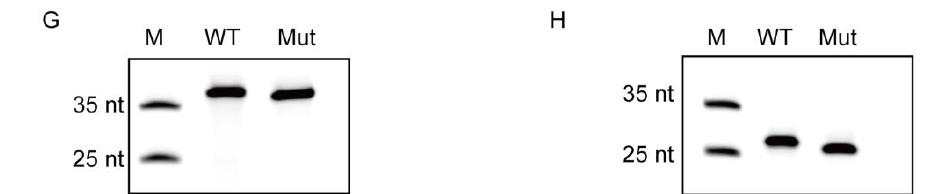
Figure 1. Identification and characterization of G4 formation in vitro. ( A ) A G-tetrad with four guanines connected by eight Hoogsteen hydrogen bonds stabilized by K + and an intramolecular G-quadruplex (G4) composed of three stacking G-tetrads. ( B ) Schematic representation of G-rich sequences at the upstream region of OriL within the PRV genome, OriL-S was located at the sense strand, while OriL-A was located at the antisense strand. ( C , D ) Circular dichroism (CD) spectra of wild-type (WT) or mutated-type (Mut) oligonucleotides of OriL-S (5 µM) and OriL-A (5 µM), which were annealed in a buffer with 50 mM LiAsO4 and 100 mM KCl. ( E , F ) Wild-type (WT), mutated-type (Mut), and WT complementary with antisense oligonucleotides (as) of OriL-S and OriL-A were subjected to native gel analysis (representative image), the corresponding illustration of G4, liner, and double-stranded DNA was directed by an arrow. ( G , H ) WT and Mut oligonucleotides of OriL-S and OriL-A were electrophoresed on denaturing gel with 7 M urea (representative image). All the oligos were labeled with FAM at the 5 (cid:48) -end, and the marker (M) was synthesized with the indicated length but did not form a secondary